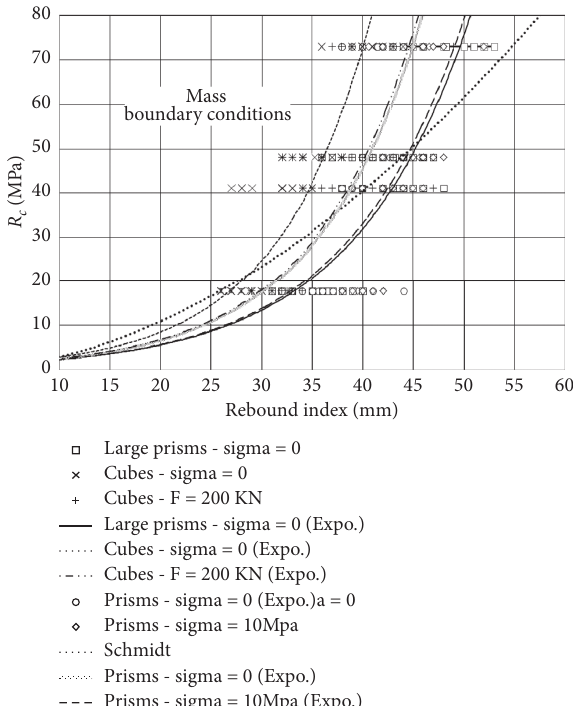
Figure 8: Calibration curves for different specimen mass and stress state. Dotted bold line: Schmidt curve. Calibration curve: R c � e a RI ; RI � rebound index; a ∈ [0.088, 0.110]; R 2 � [0.66, 0.93]. Inside any dataset, C.o.V. ≤ 9% for vanishing stress; C.o.V. ≤ 10% for com- pressed prisms (5 and 10MPa,